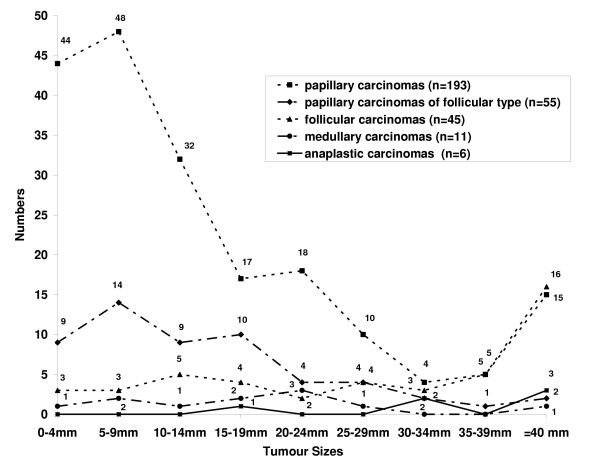
Number of TCs stratified by histological type and tumour size; n = 310 cases; period 1990–1999.